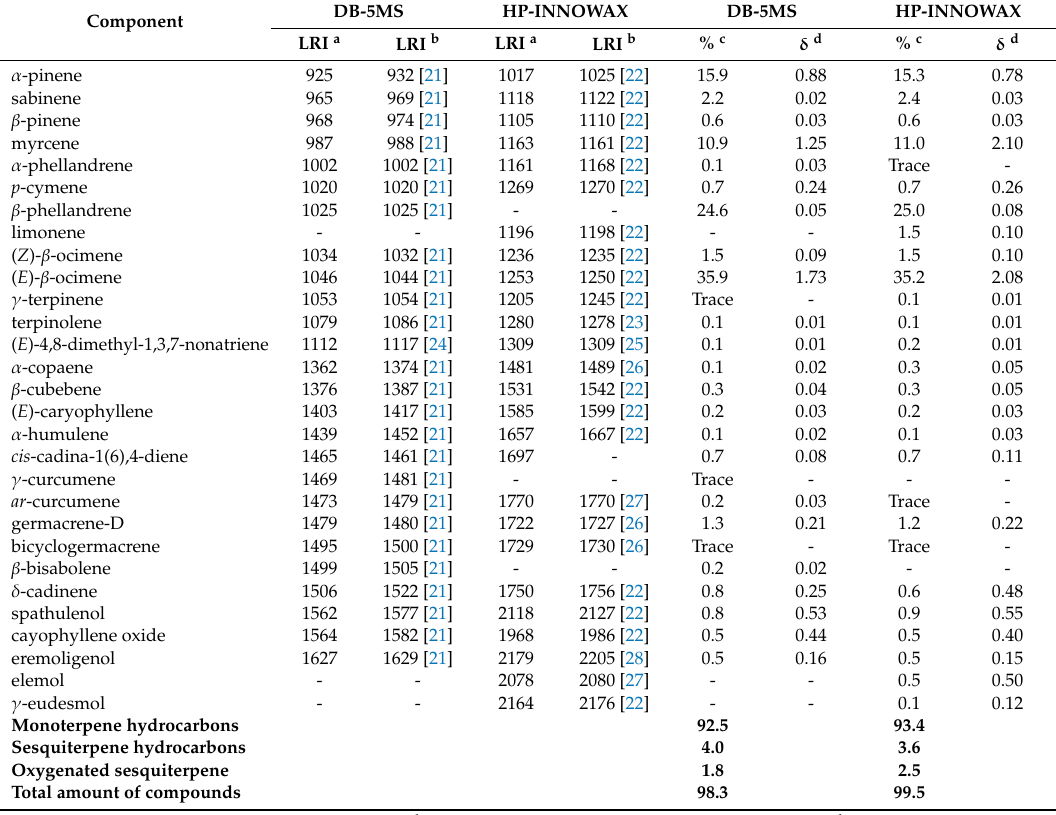
Table 1. Chemical composition of Coreopsis triloba S.F. Blake essential oil.